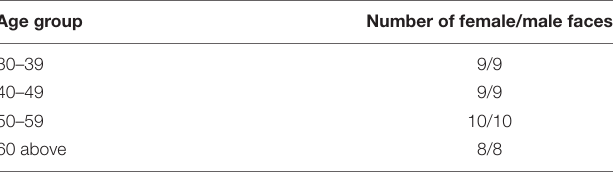
TABLE 1 | Number of each age group of targets in Study 3.